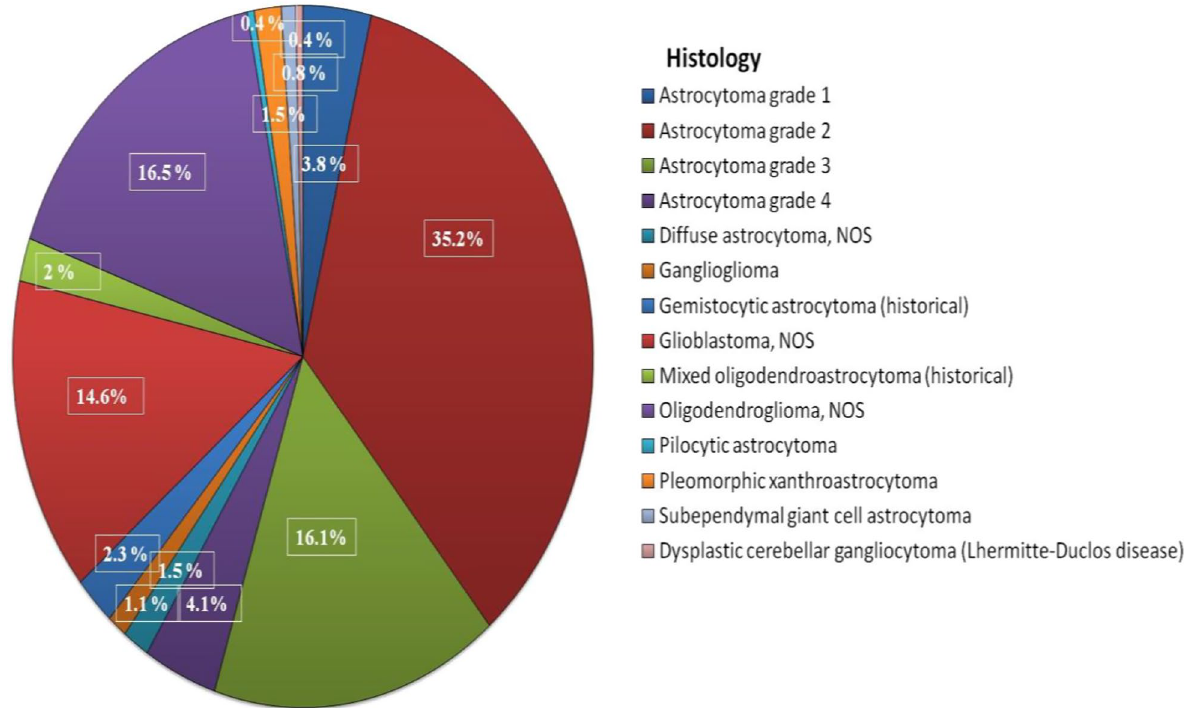
Fig. 3 Histological distribution of gliomas, glioneuronal tumors, and neuronal tumors in the adult cohort